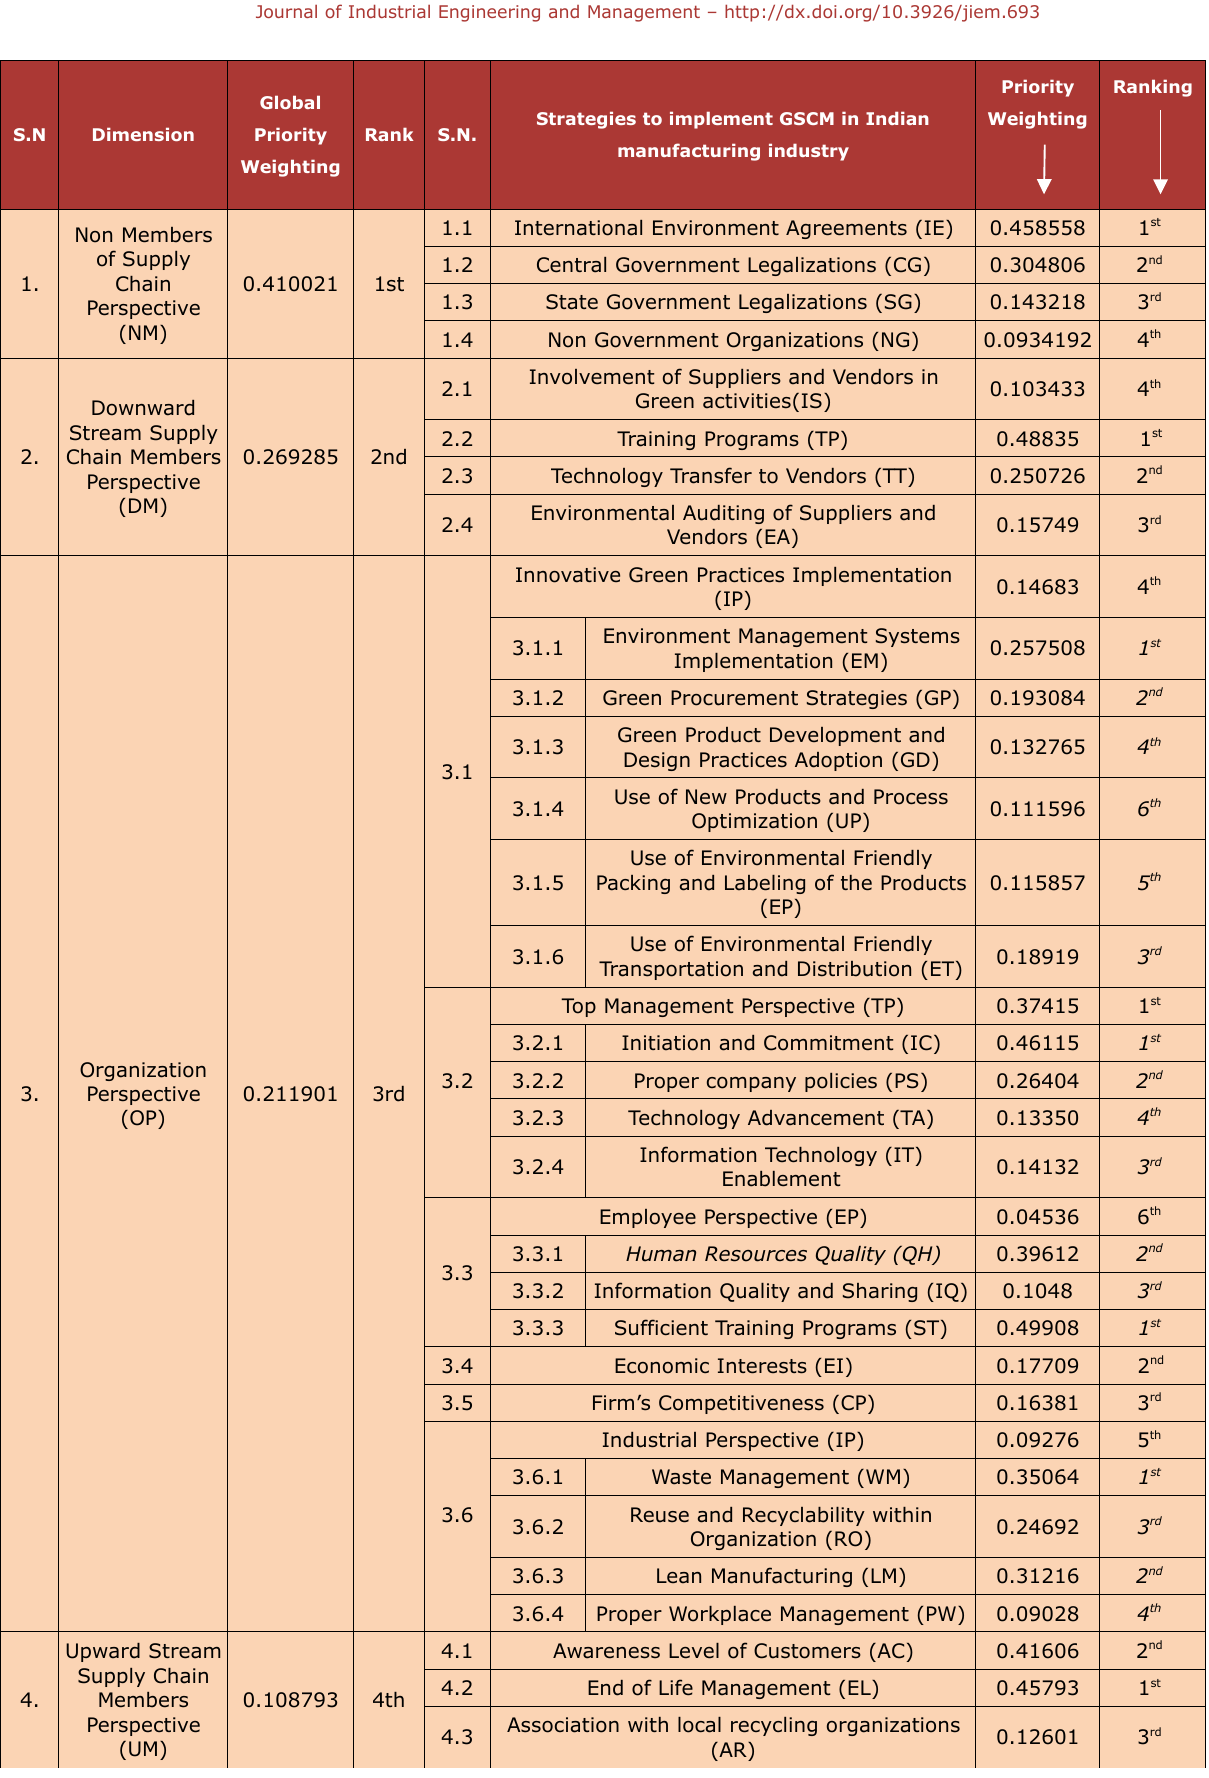
Table 7. The priority weighting and ranking of strategy to implement